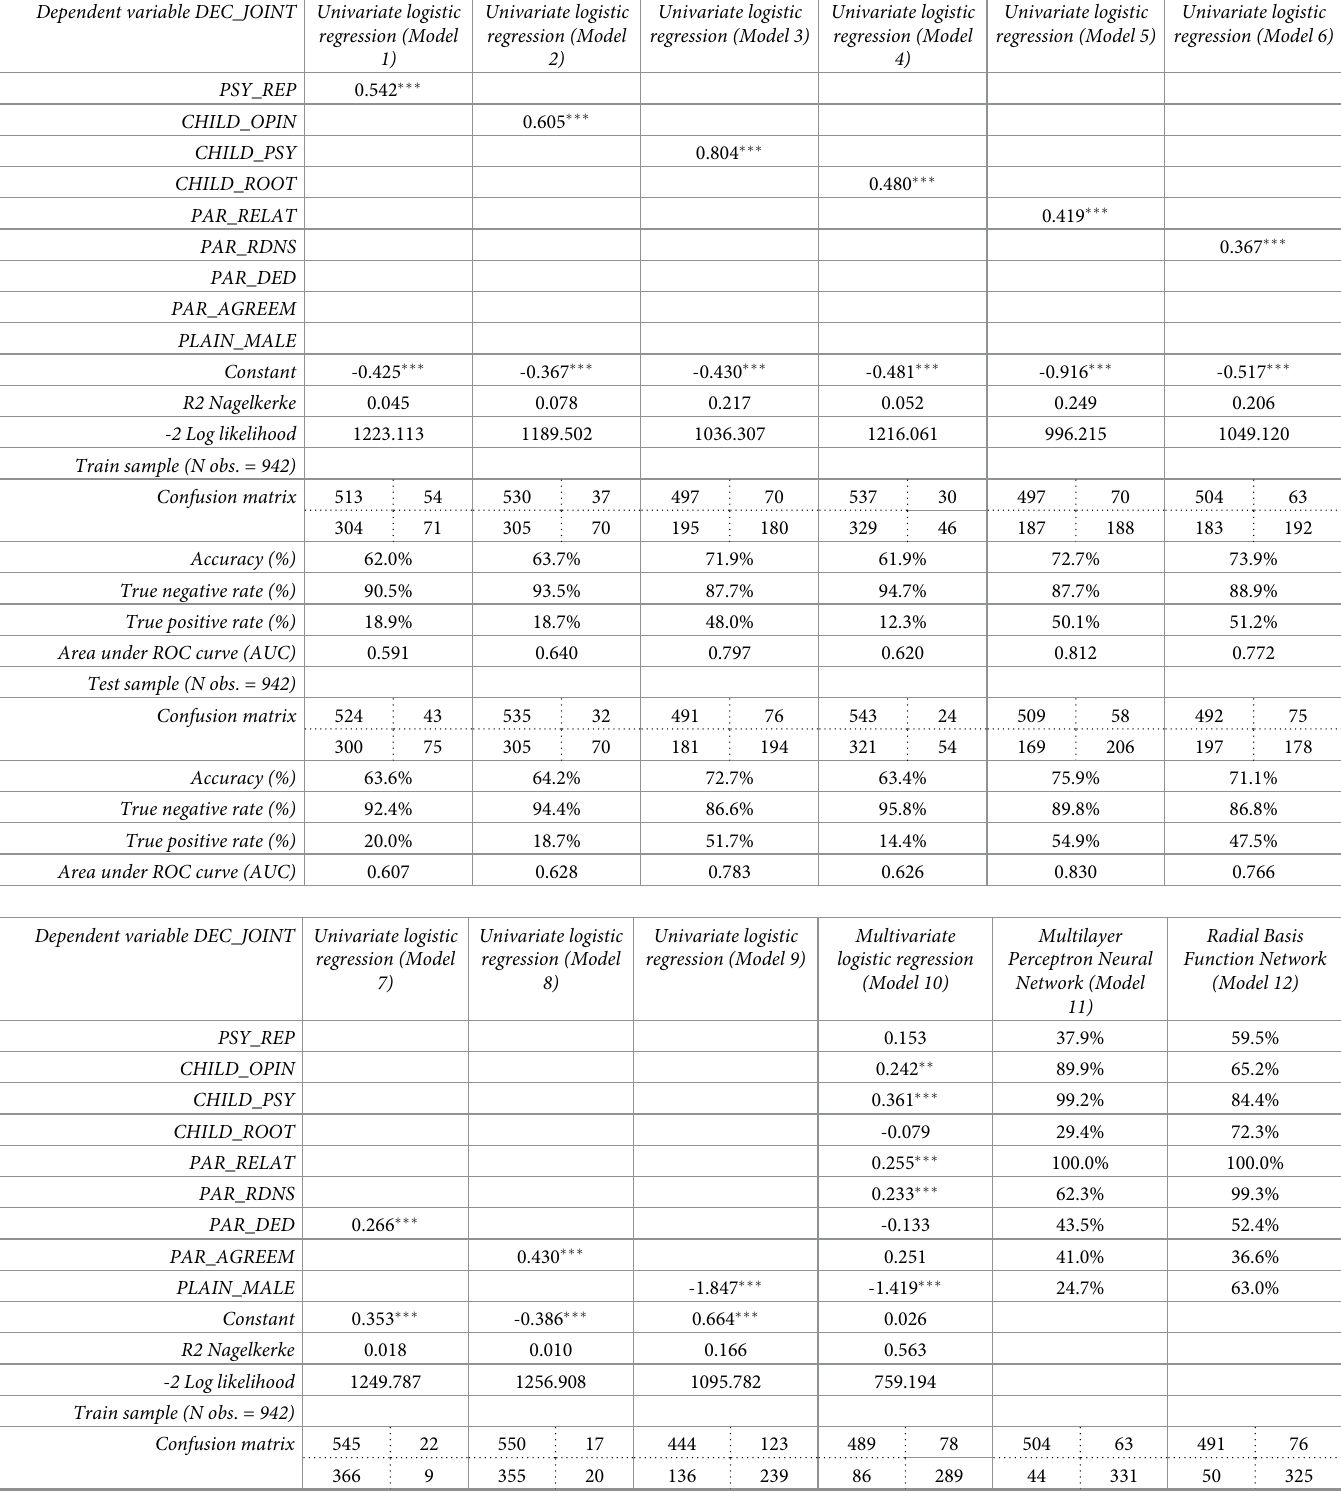
Table 7. Logistic regression analysis and neural network models for predicting court decisions on custody (DEC_JOINT). Dependent variable DEC_JOINT Univariate logistic regression